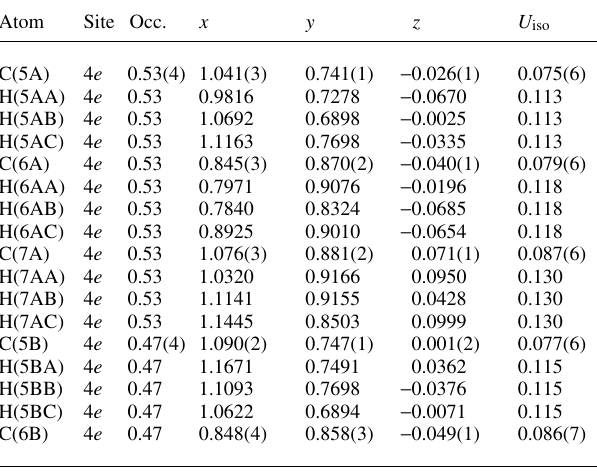
Table 2. Atomic coordinates and displacement parameters (in Å 2 )